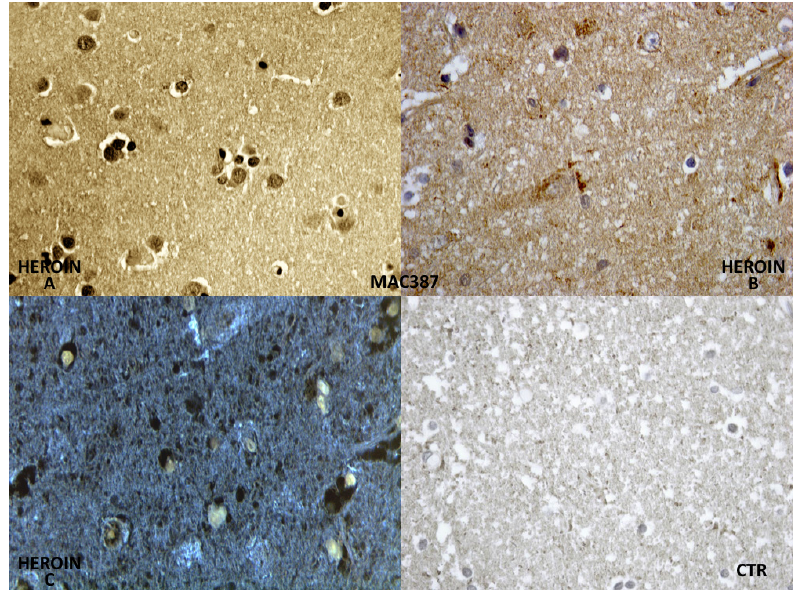
Constant and strong positivity was found in brain macrophages (MAC 387) (Figure 4). Figure 4. The reaction with CD68 (MAC387) showed a constant and strong positivity in brain macrophages ( A , B ); Evident microglia fluorescence by use of the confocal microscope ( C ); Negative control case